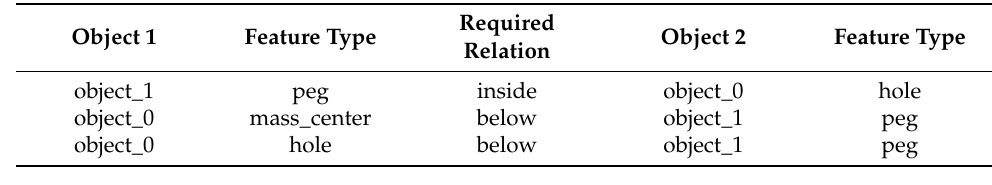
Table 3. A set of rules representing learned skill requirements.